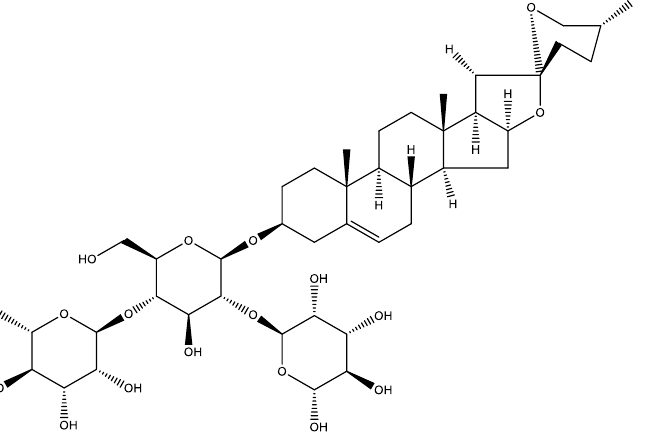
Figure 1. Chemical structure of dioscin; produced by ChemDraw 12.0,2, PerkinElmer Inc, USA .